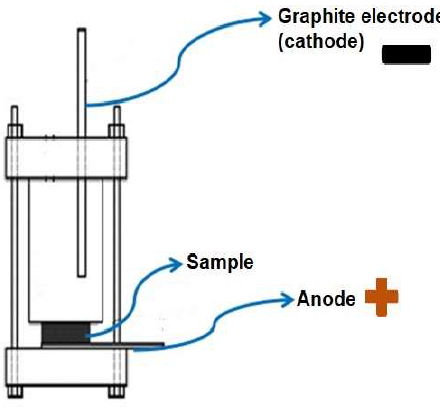
Figure 1. Schematic representation of the electrochemical cell for nanostructure modification.